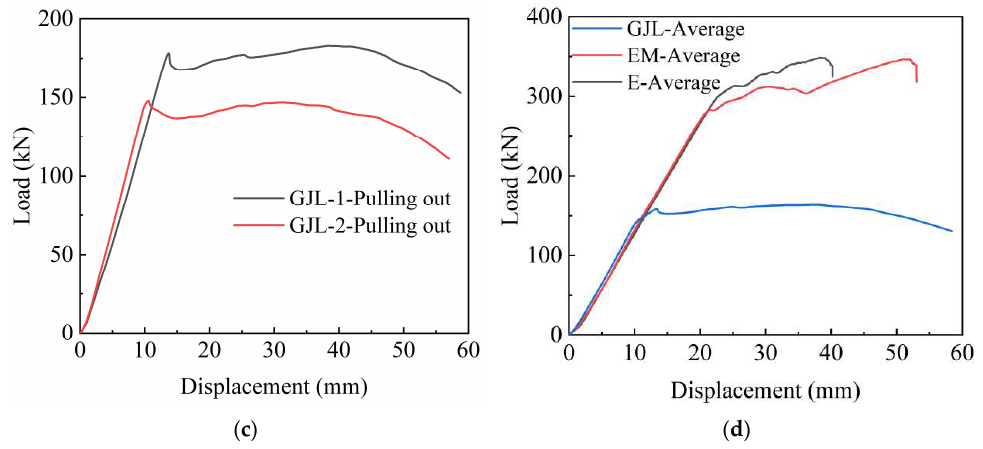
Figure 13. Force-displacement relationship curves of bonding medium control group. ( a ) Force-displacement curves of E-X test group; ( b ) force-displacement curves of EM-X test group; ( c ) force-displacement curves of GJL-X test group; ( d ) average force-displacement curves.